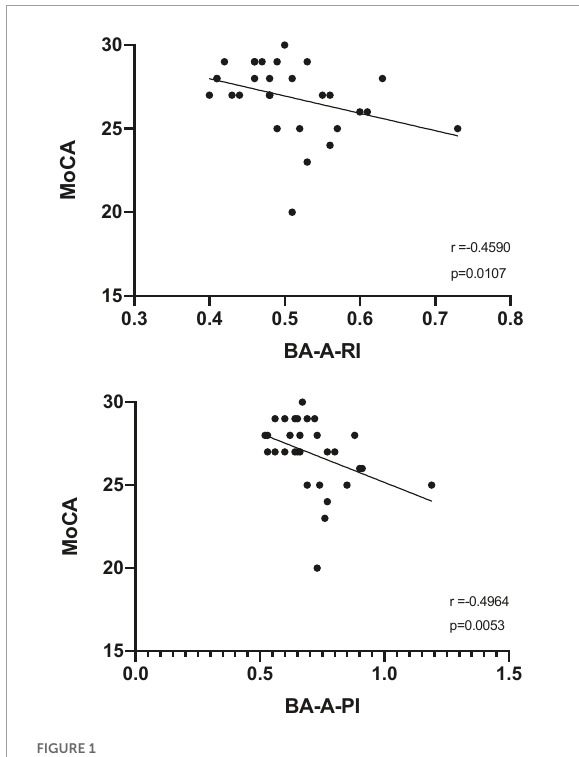
FIGURE1 Spearman correlation analysis between Montreal cognitive assessment score (MoCA) and the resistivity index (top panel) and pulsatility index (bottom panel) from the basilar artery after the breath-holding test (BA-A-RI and BA-A-PI,